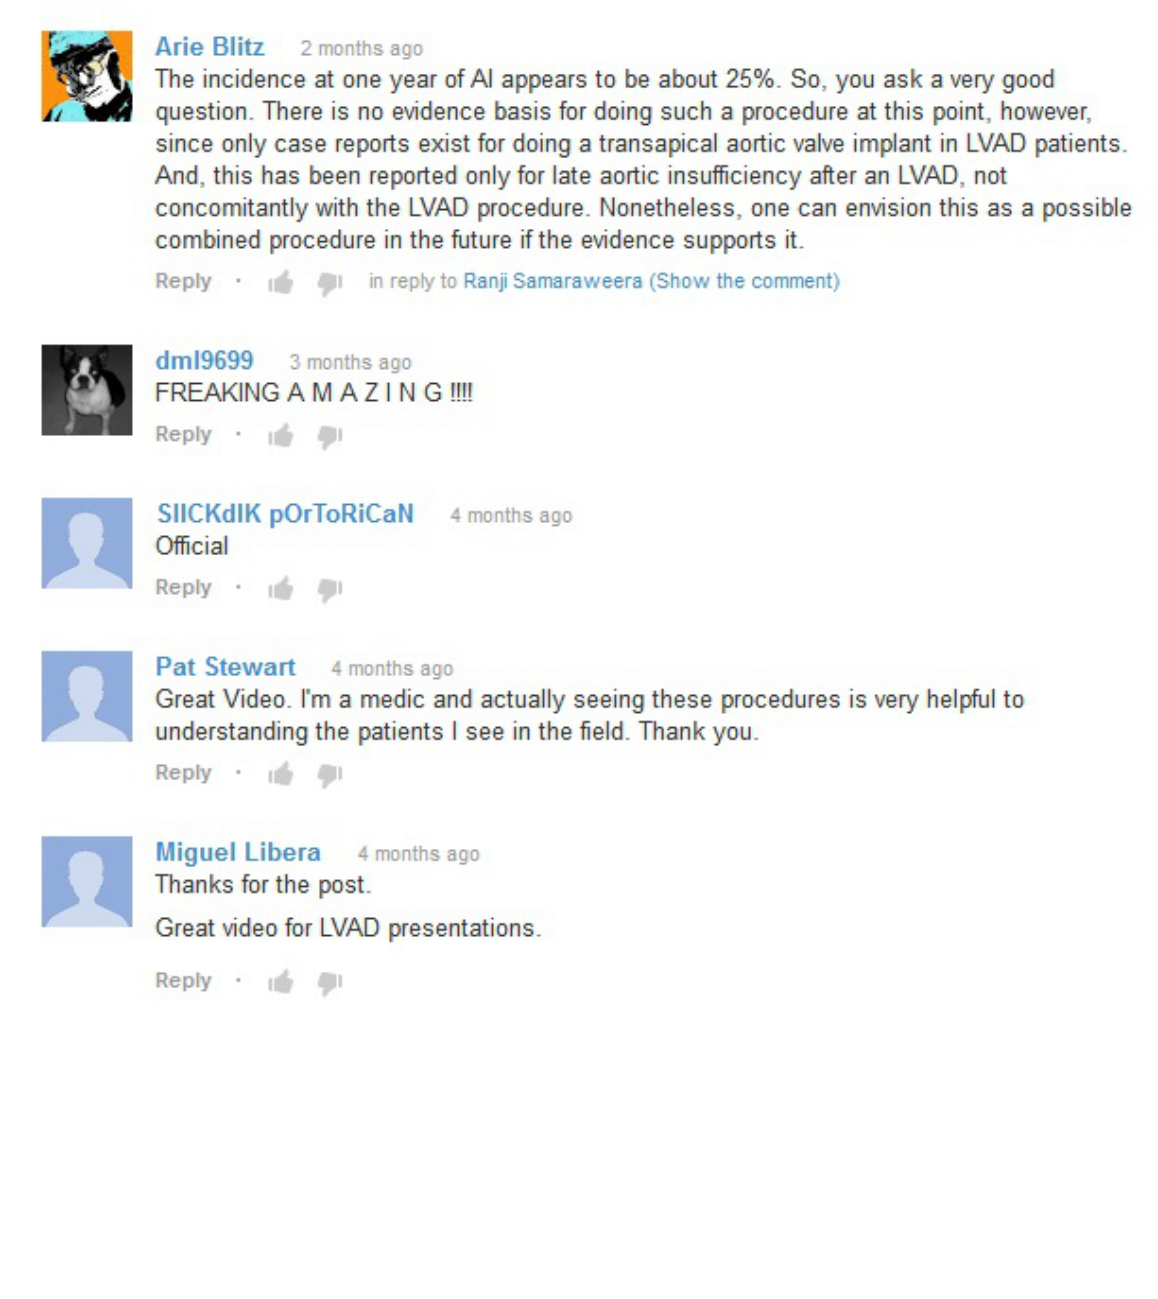
Figure 4. A screenshot of the comments from Web viewers (on April 12,